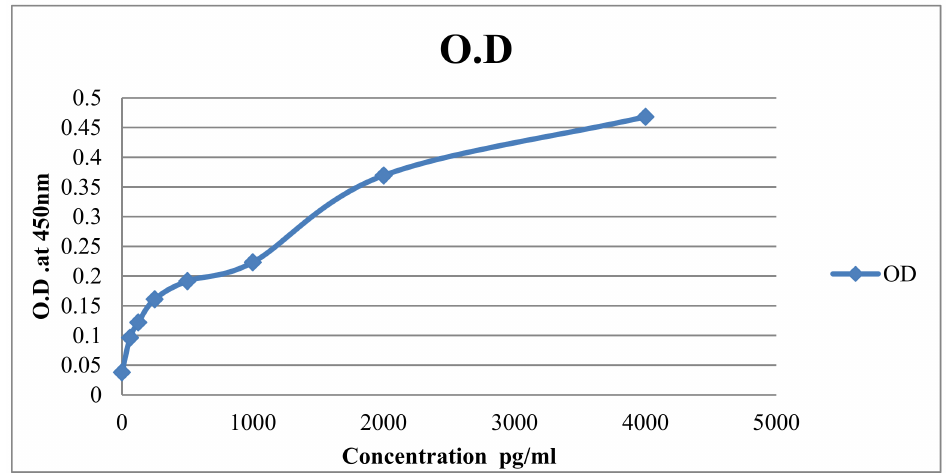
Figure 1. Standard curve: Results of a typical standard run of lactoferrin ELISA kit is shown above. The X-axis shows the concentration of lactoferrin, and the y-axis shows the O.D value.